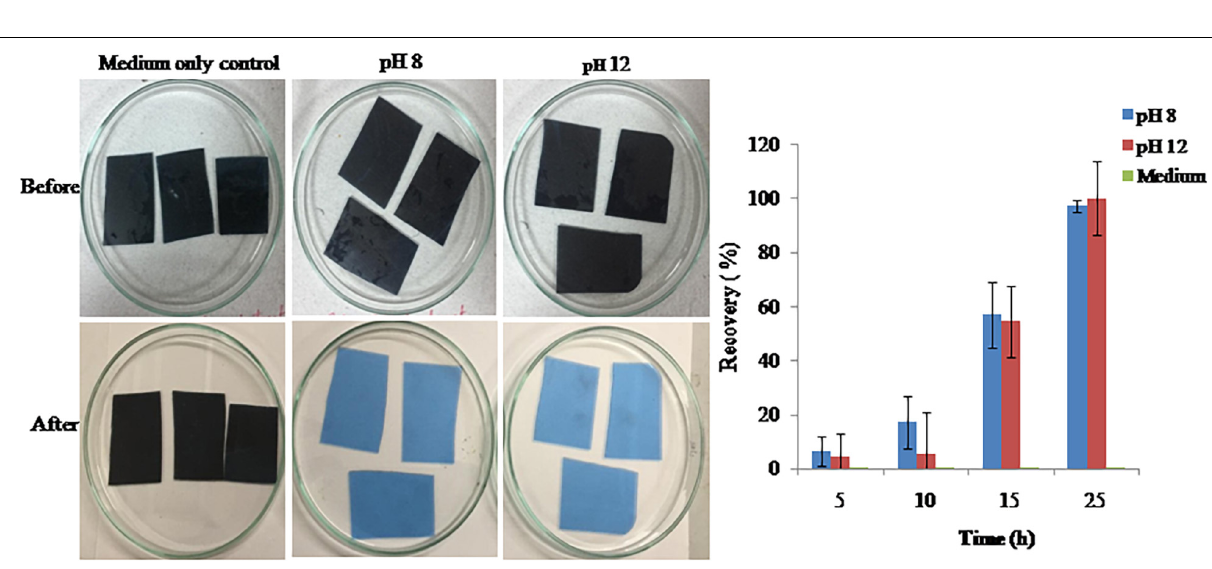
FIGURE 7 | Hydrolysis of gelatin layer from used X-ray films by